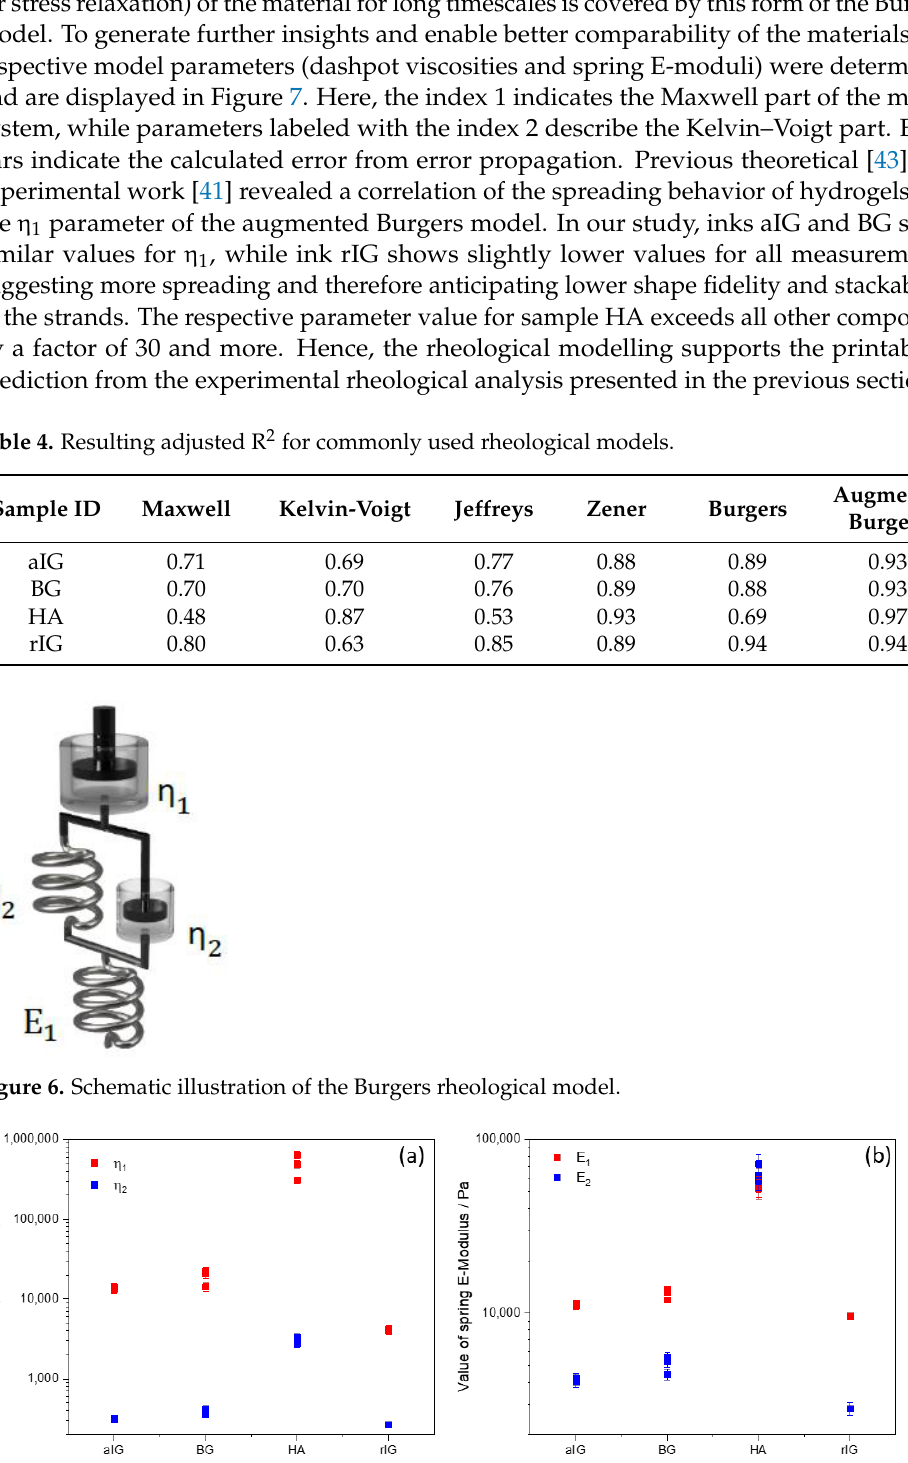
Figure 7. Resulting model parameters for the augmented Burgers model for dashpot viscosity ( a ) and spring Young’s modulus ( b ) for the different investigated inks.